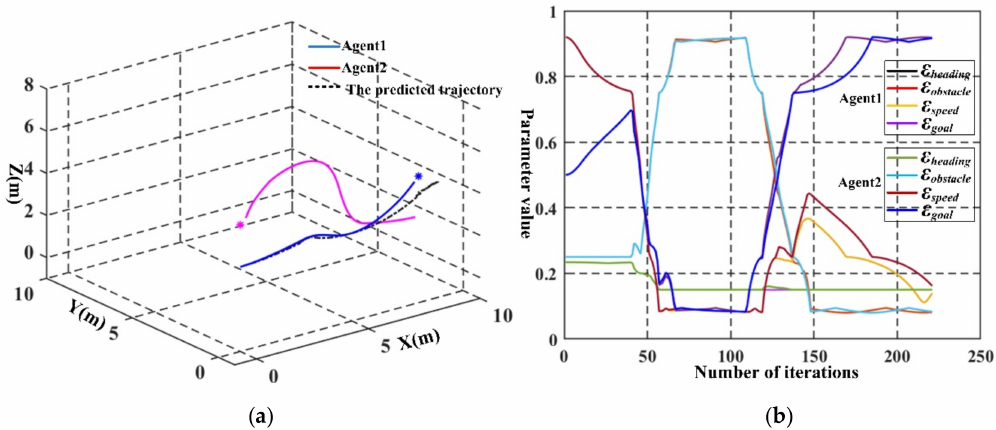
Figure 13. ( a ) planning trajectory and ( b ) the changes in the weight of reward value during iterations in two dynamic obstacle avoidance